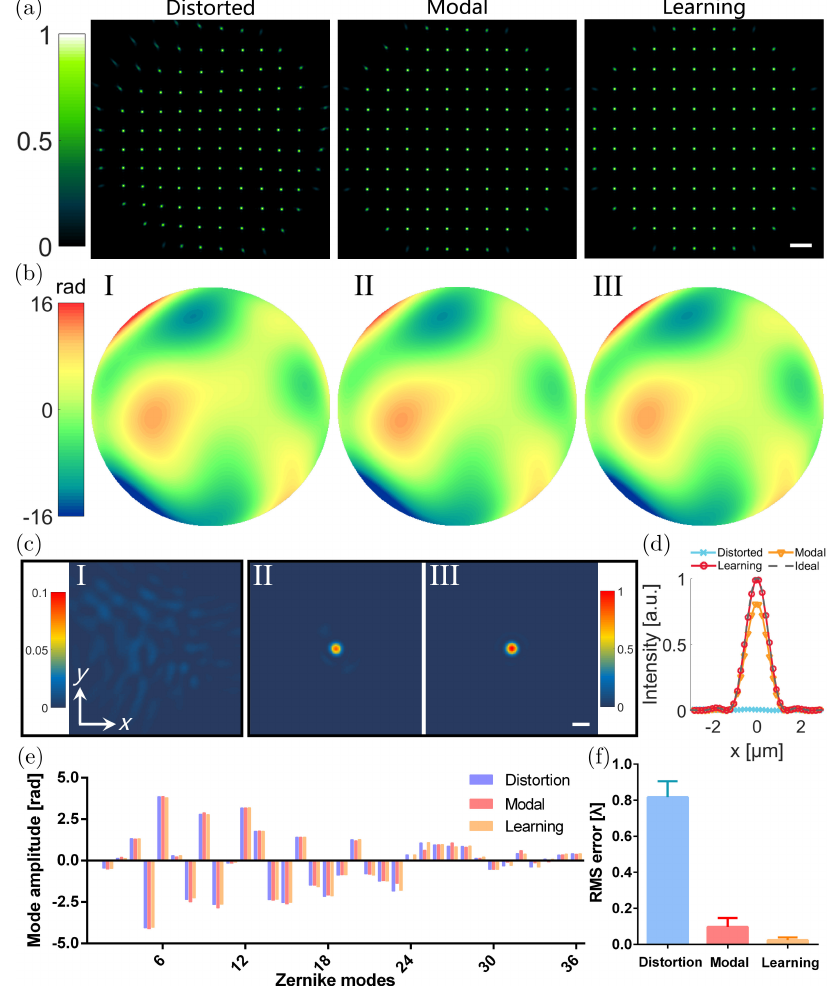
Fig. 7. Comparison of distortion detection results between modal-based method and our method. (a) The normalized intensity distribution of distorted spot pattern (left), the pattern corrected by modal approach (middle) and learning approach (right). The scale bar is 400 (cid:2) m. (b) The original distortion \I", the distortion detected by modal approach \II" and the learning approach \III". (c) The intensity distributions of the distorted PSF \I", the PSF corrected by modal approach \II" and learning approach \III". The scale bar is 2 (cid:2) m. (d) Intensity distributions of PSFs in x -direction. (e) The comparison of the Zernike mode coe±cients. (f) The RMS error in phase residuals of 1024